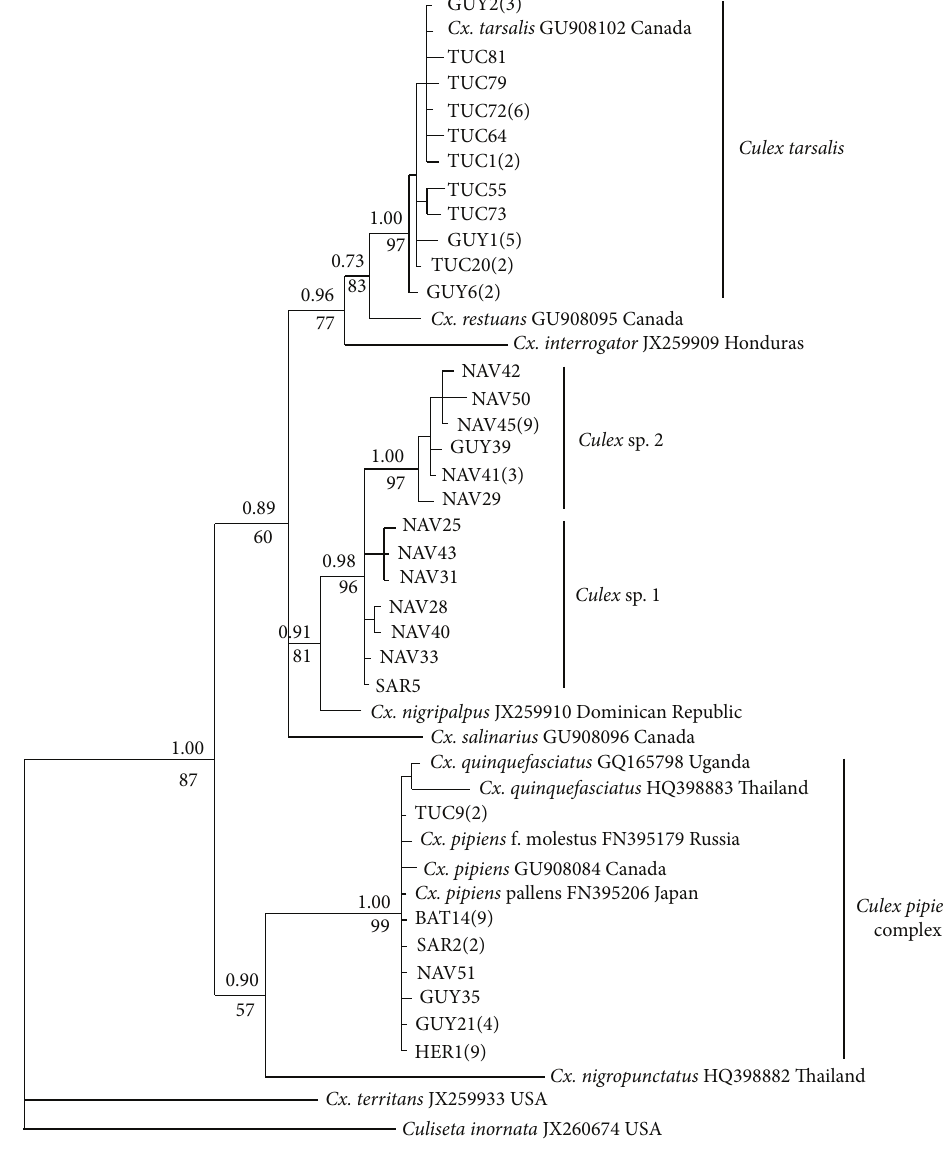
Figure 2: Bayesian 50% majority rule consensus tree based on COI sequences (611bp) showing relationships among haplotypes of Culex spp. from the Sonoran Desert region and GenBank sequences from several recognized species worldwide. Clade support expressed as posterior probabilities is shown above the branches. Bootstrap support values for the maximum parsimony (MP) tree (length = 235; CI = 0.698; RI = 0.677;154variablesites;90parsimonyinformativesites)areshownbelowthebranches.Branchterminalsarelabeledwithlocalityabbreviation and sample identification number (see Figure 1). The total number of identical haplotypes from each region is shown in parentheses following the listed haplotype. The scale shows substitutions per